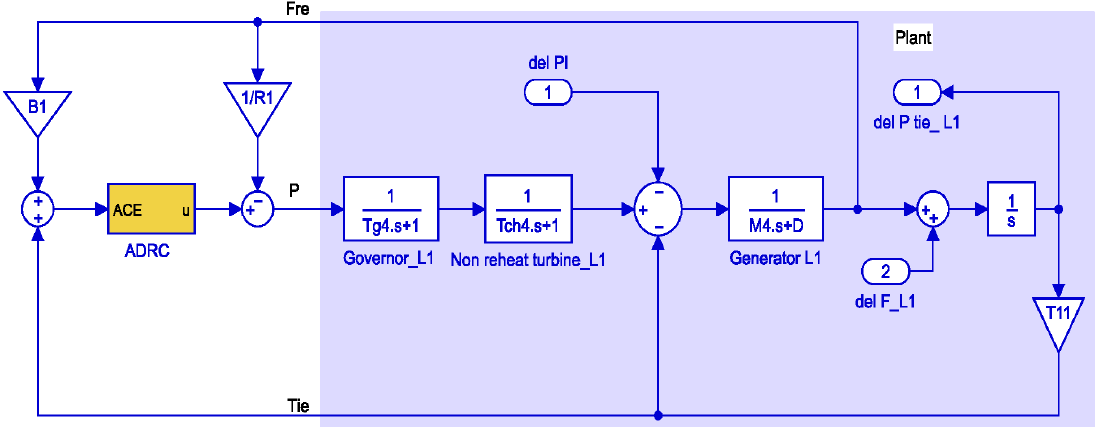
Figure 7. Dynamic model of load change from L 1 to G 1 (block B in Figure 6).